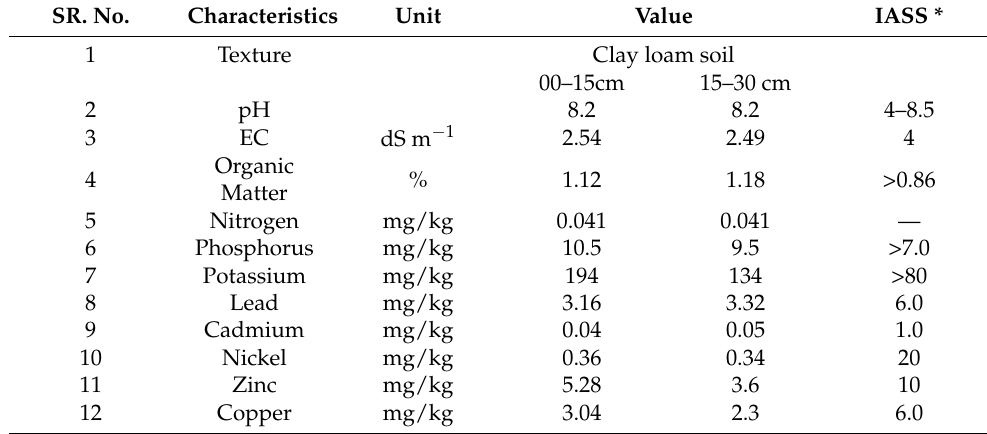
Table 1. Composition and analysis of soil before experiment. SR. No.